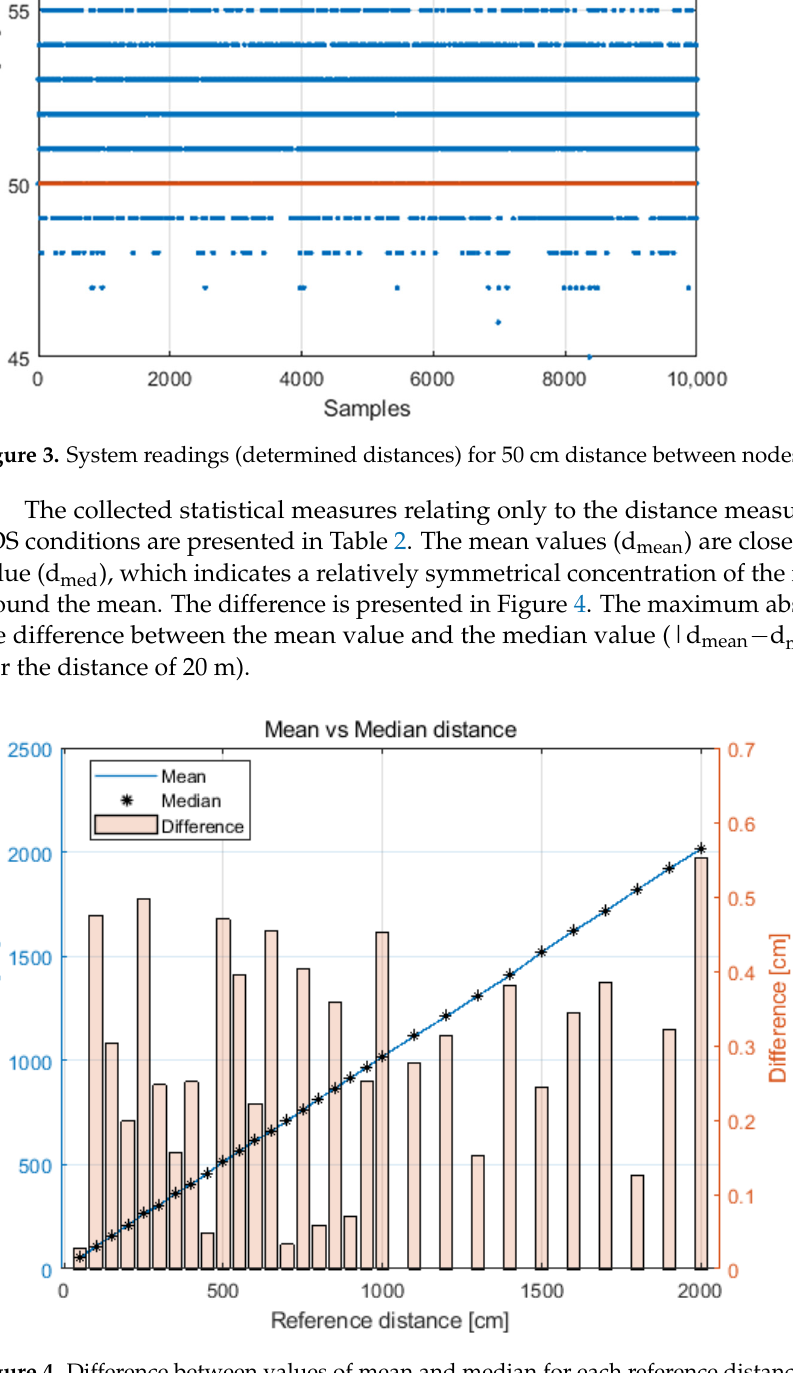
Figure 4. Difference between values of mean and median for each reference distance.